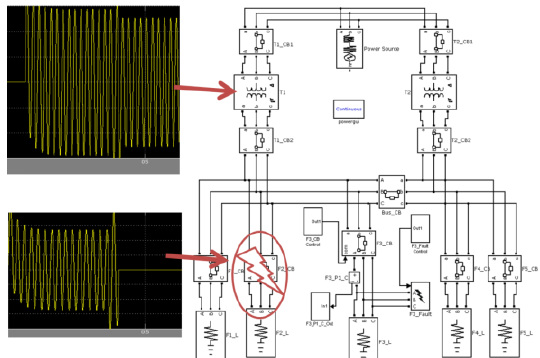
Figure 13. Co-simulation result of the sympathetic trip protection